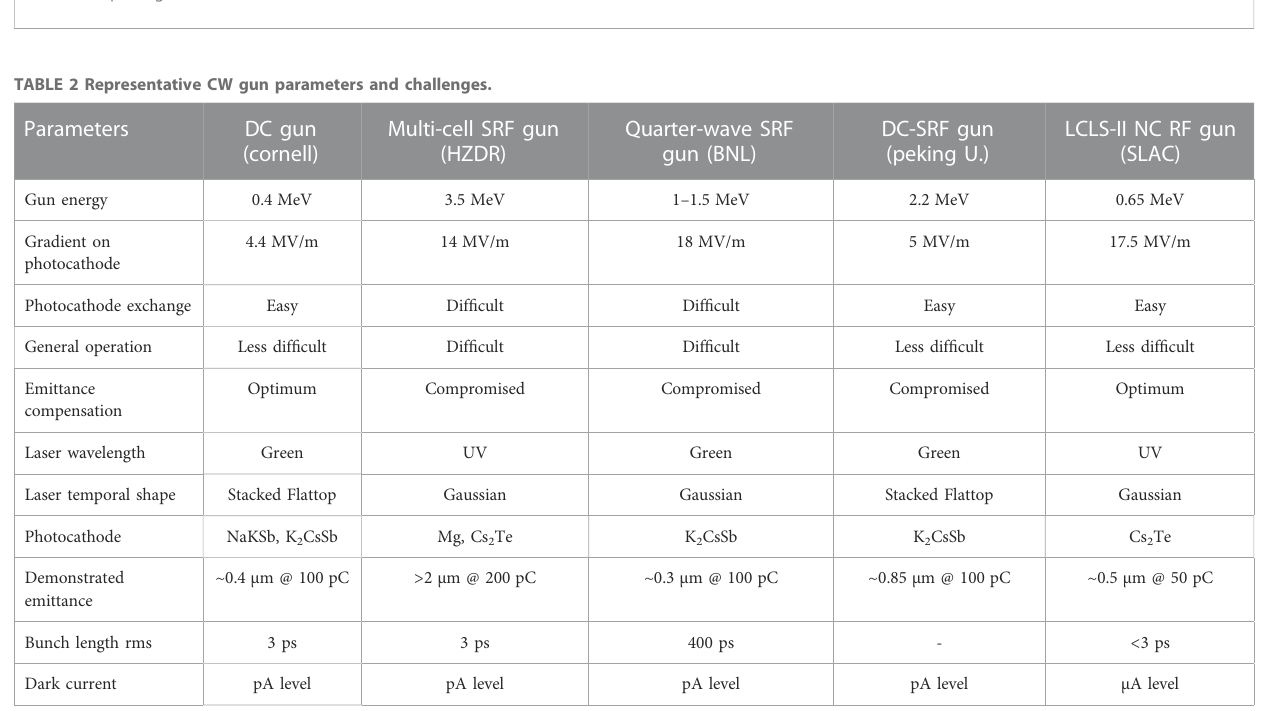
FIGURE 10 Improvementstothesparegun (A) ellipticalshaped(b/a=0.17)edgesonthecathodeplugandnose, (B) stainlesssteel(SS)insertsatthecathodeand anode openings.